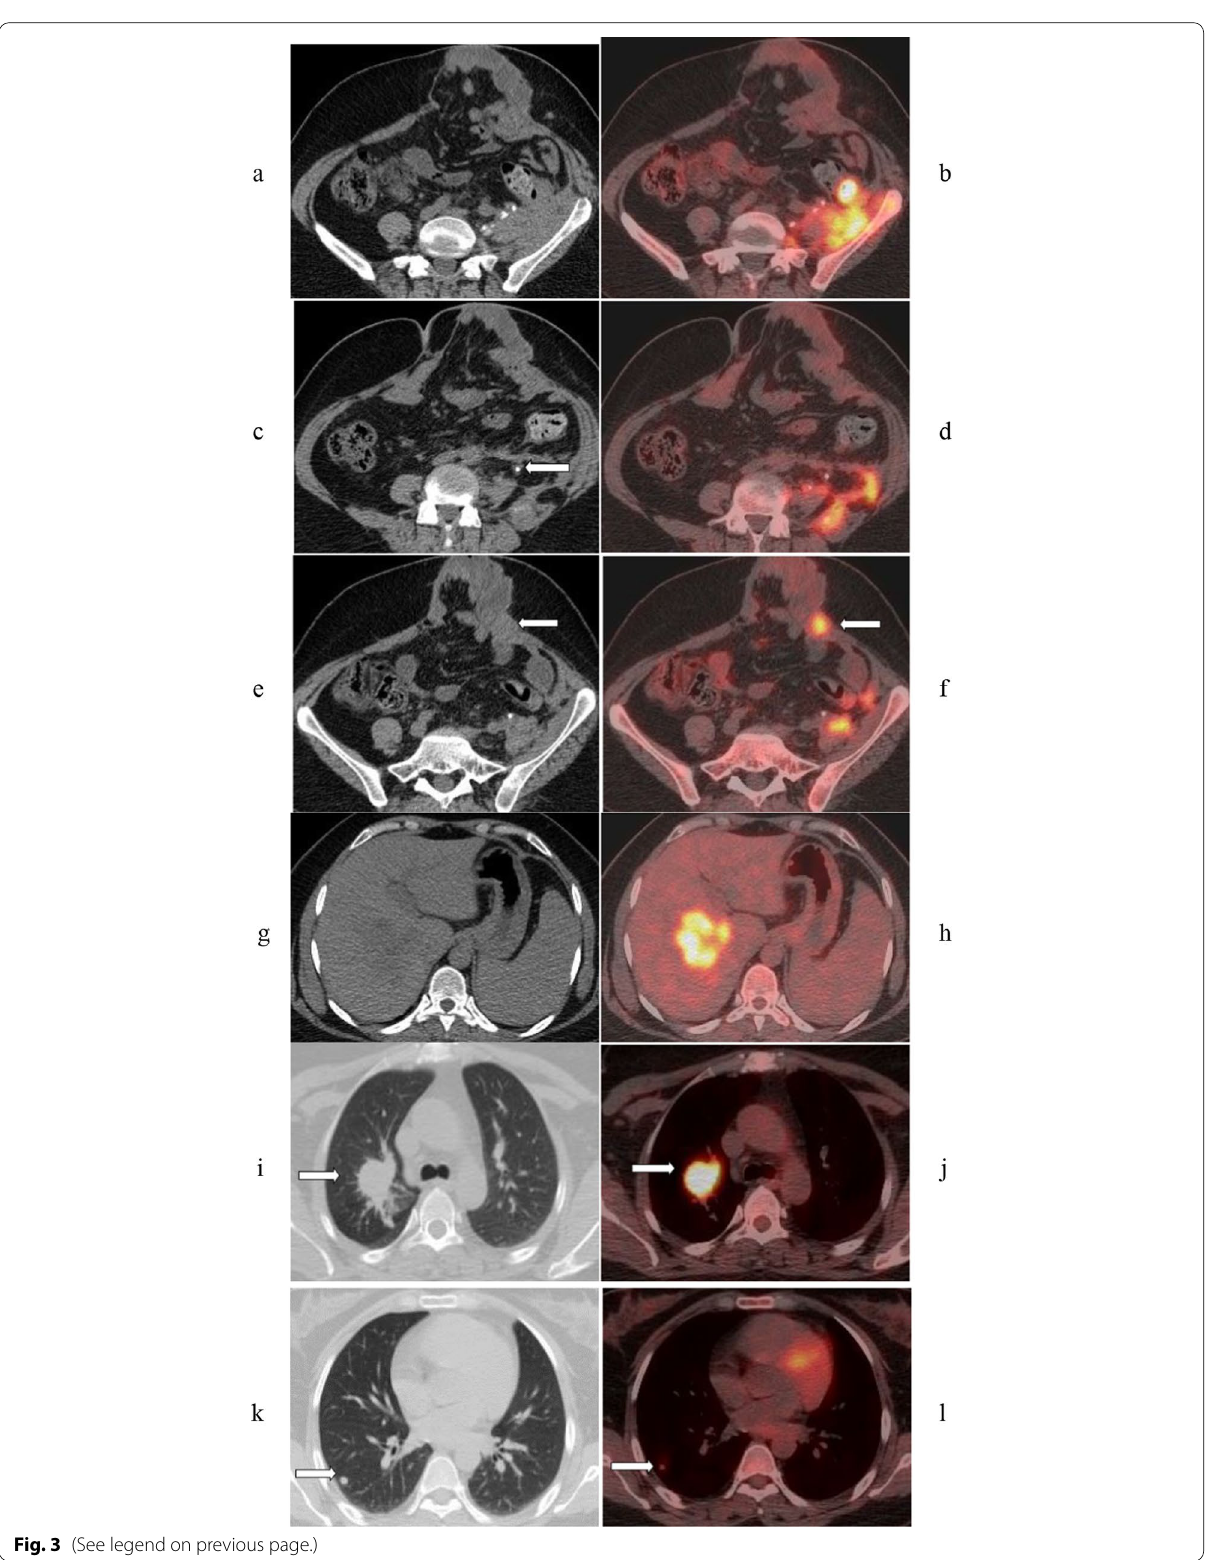
Fig. 3 (See legend on previous